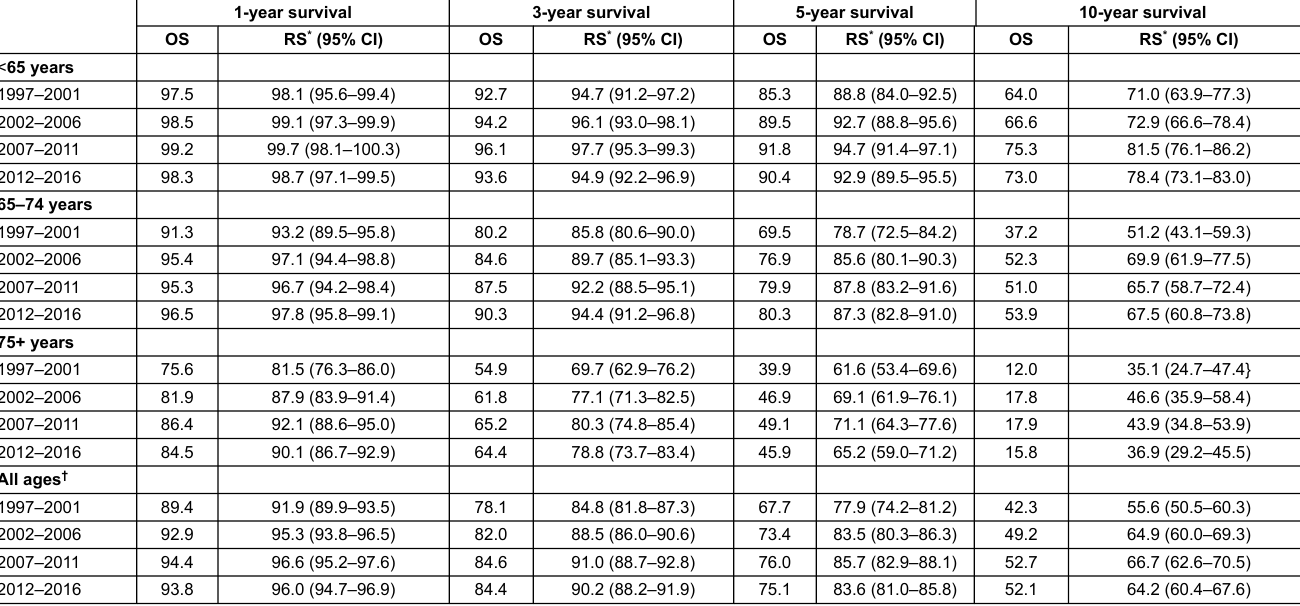
Table S5: Observed and relative survival of chronic lymphocytic leukaemia / small lymphocytic lymphoma patients by age-group and period.